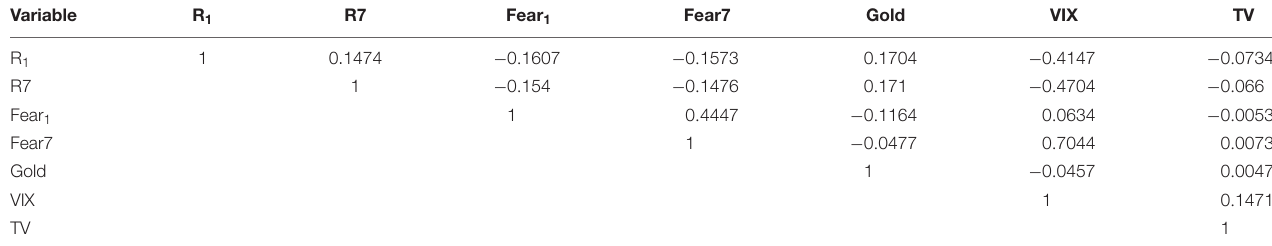
TABLE 5 | Results of bivariate correlations of the targeted variables.